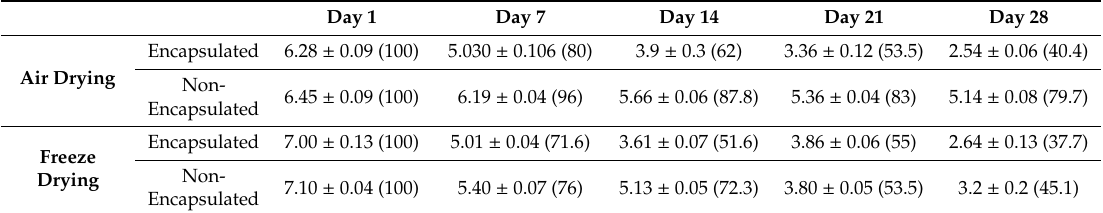
Table 3. Microbial content of L. salivarius spp. salivarius encapsulated and non-encapsulated (Log CFU / g dried ) in dried apples stored for 28 days. The number in brackets indicates the survival of microorganisms in percentage. Results expressed as mean ± standard deviation of four